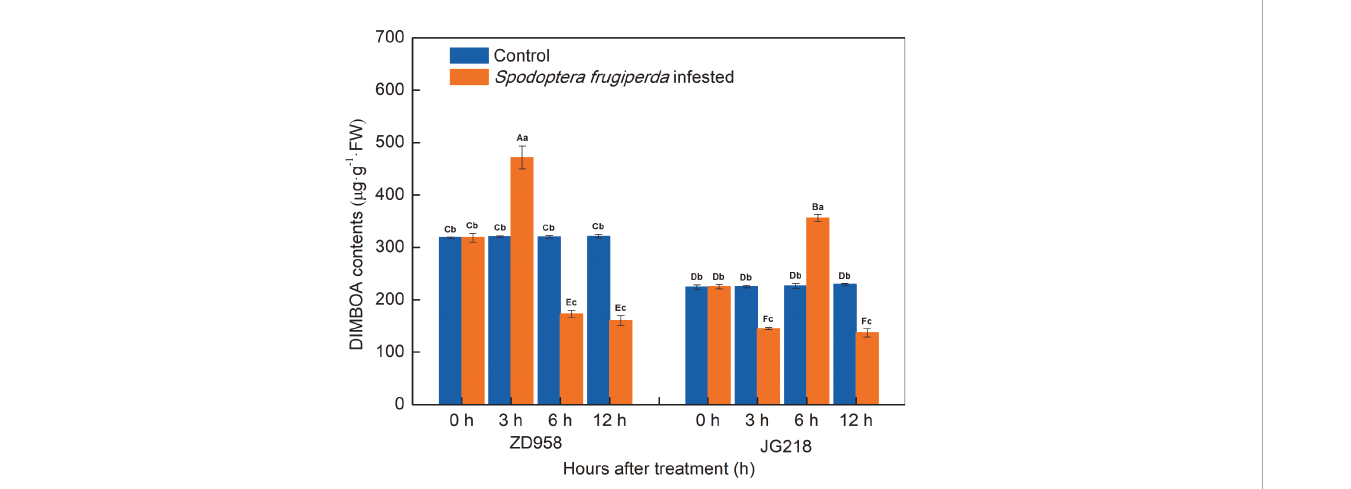
FIGURE 6 Effect of S. frugiperda infestation on 2,4-dihydroxy-7-methoxy-1,4-benzoxazin-3-one contents in maize leaves. Data are shown as means ± SD ( n = 3, every n represents the mean of three seedlings). Different letters indicate signi fi cant differences at P < 0.05. Capital letters represent differences between the two maize cultivars, while lowercase letters indicate differences between treatments within the same